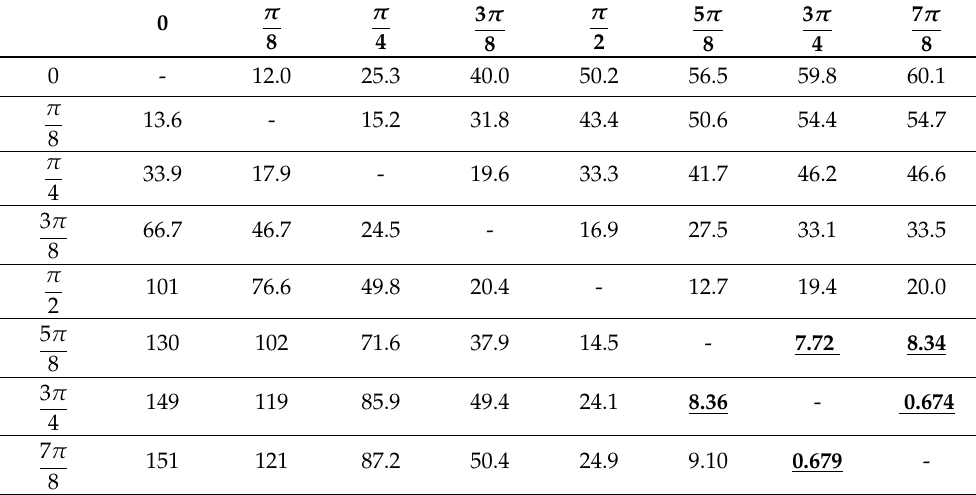
Table 5. Percent error at peak magnification over 100 Monte Carlo simulations, between a microlens- ing photometric curve with Φ shown in the first row, compared to the photometric curve with Φ in the first column. Error values for R = 7000 km. Values in bold underline show where % error between the two curves is less than 10%.